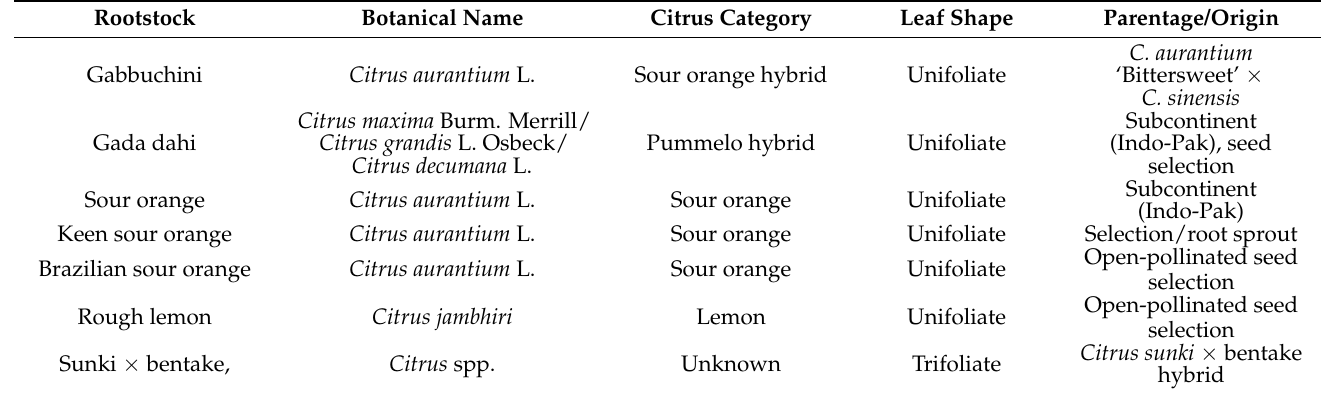
Table 1. Characteristics of citrus rootstocks used in this